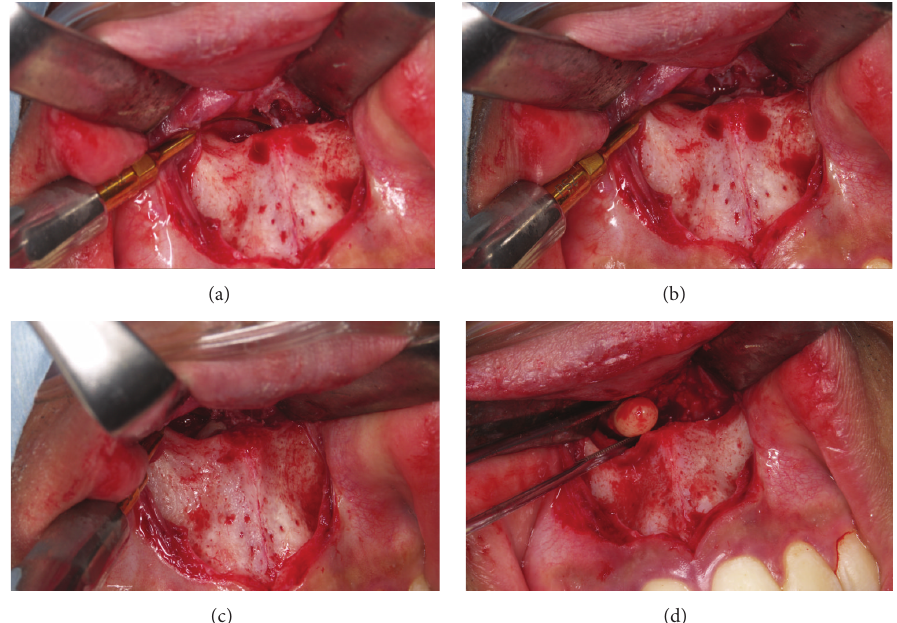
Figure 2: A trough around the crown of the impacted supernumerary tooth aided the use of piezosurgery from the floor of the nasal cavity in the restricted field of view. The buccal (a) and palatal (b) bone over the impacted supernumerary tooth (c) showing the uncovered impacted supernumerary tooth crown. (d) Extraction of deeply impacted supernumerary tooth of the anterior maxilla from the nasal cavity side.